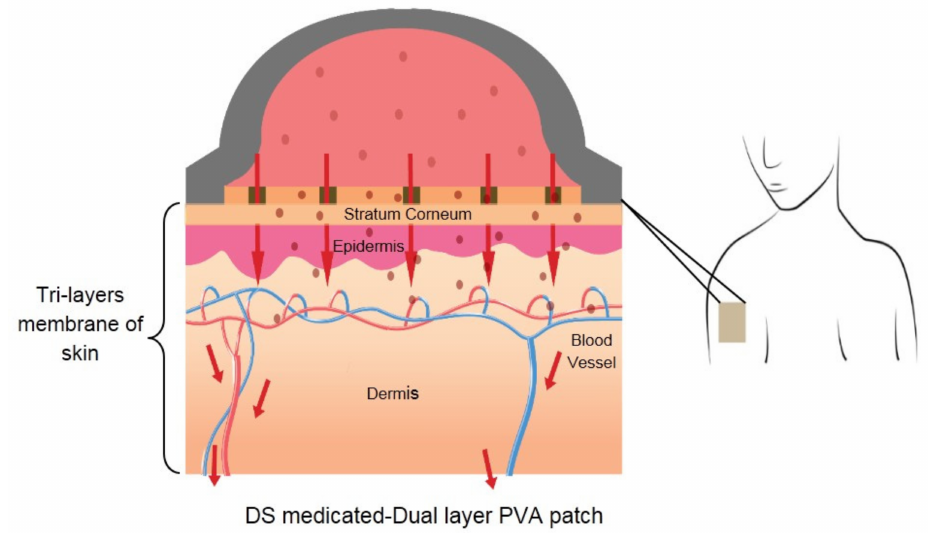
Figure 11. Transdermal mechanism of DS-medicated dual layer PVA patch through